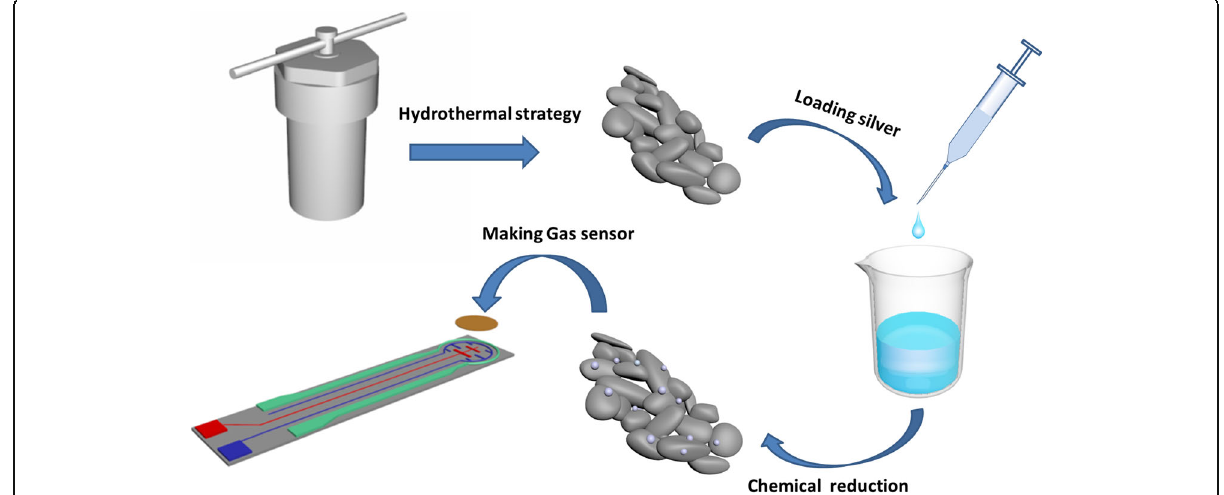
Fig. 1 Schematic illustration of the preparation of Ag-functionalized In 2 O 3 nanoparticles and screen